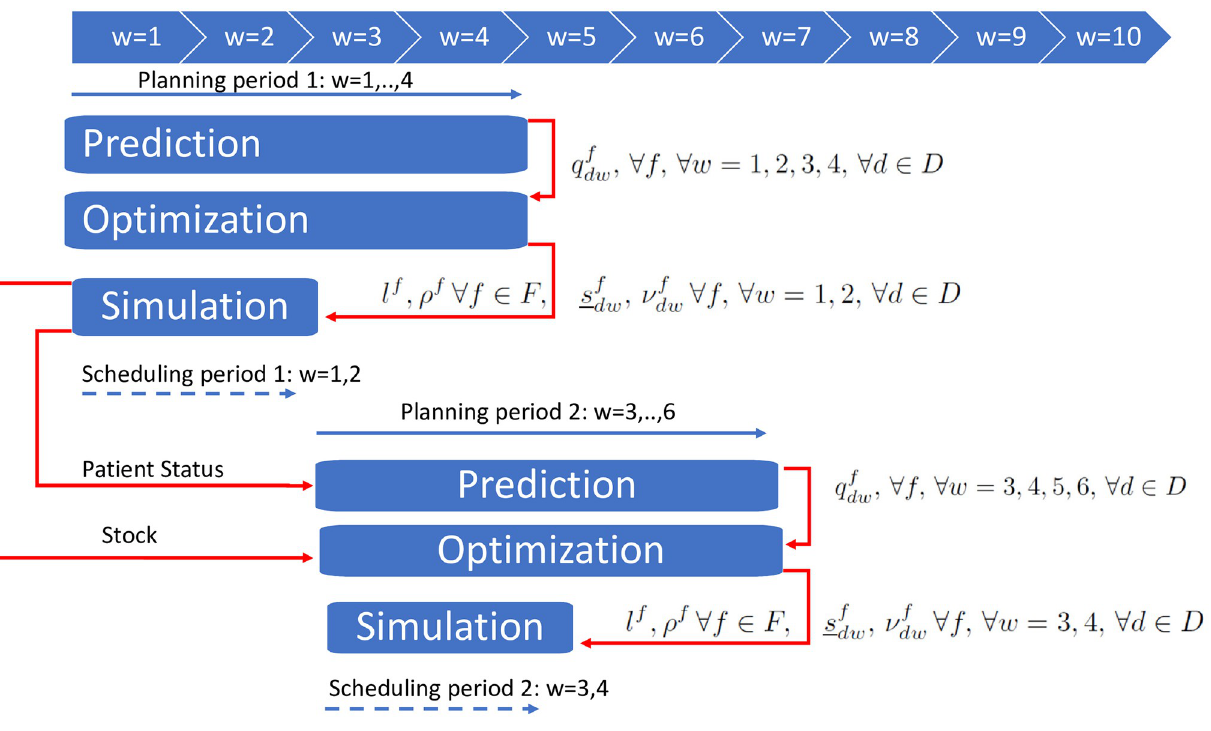
Fig 3. System components and their